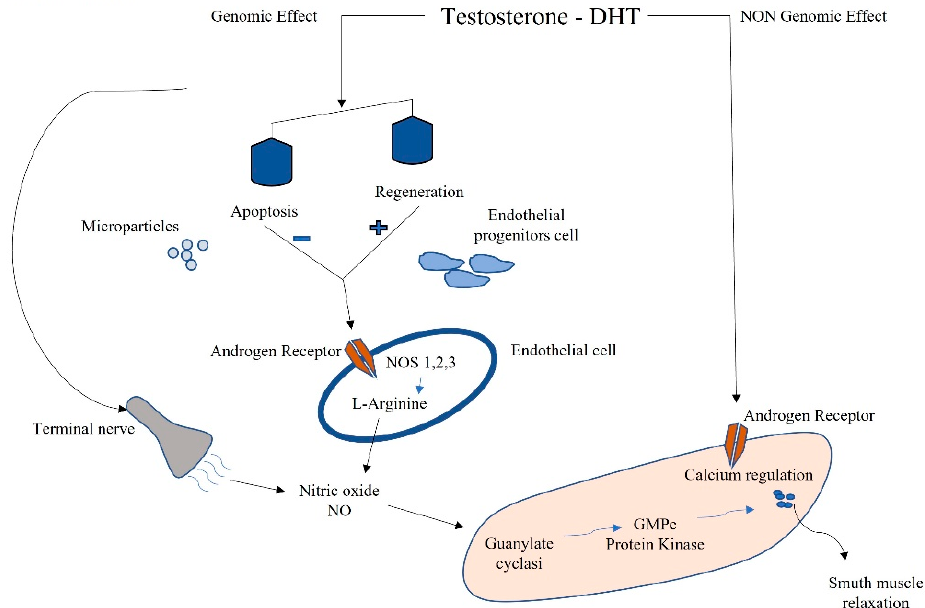
Figure 2. Schematic connection between immune microparticles, endothelial progenitor cells, and androgens in corpora cavernous endothelium.